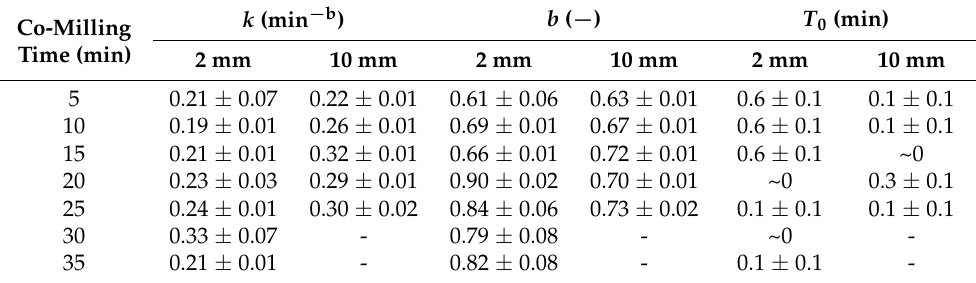
Table 4. Dependence of the values of parameters k , b , and T 0 calculated according to the Weibull model for co-milled MLX samples with 15 wt.% SLS with two sizes of grinding balls (2 and 10 mm) on the co-milling